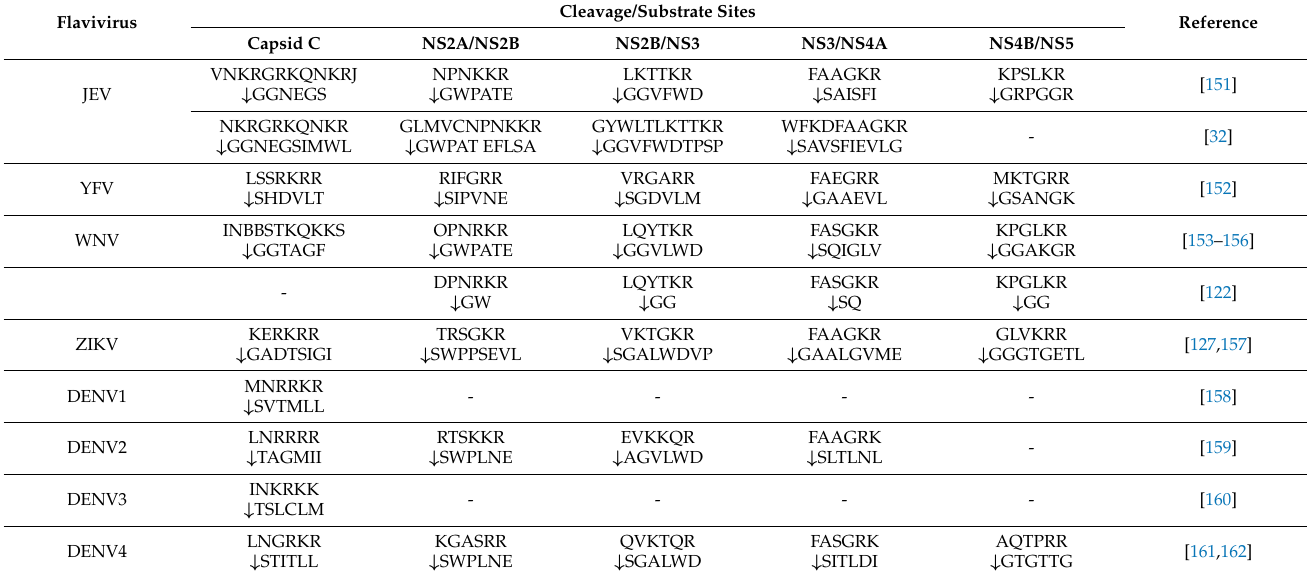
Table 1. Cleavage sites from various flaviviruses: Arrowheads indicate the NS2B-NS3 protease- susceptible cleavage positions in the polyproteins of various flaviviruses.